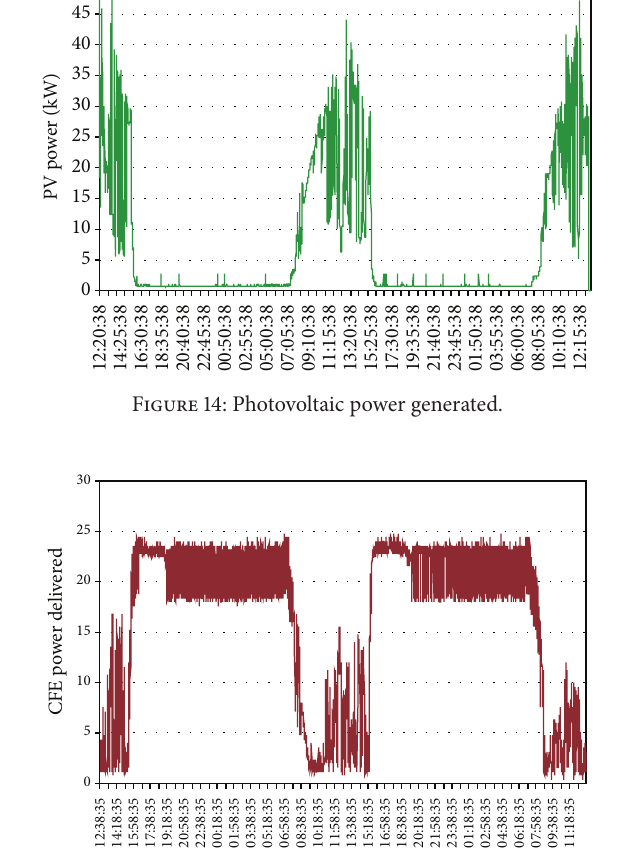
Figure 15: CFE power delivered.